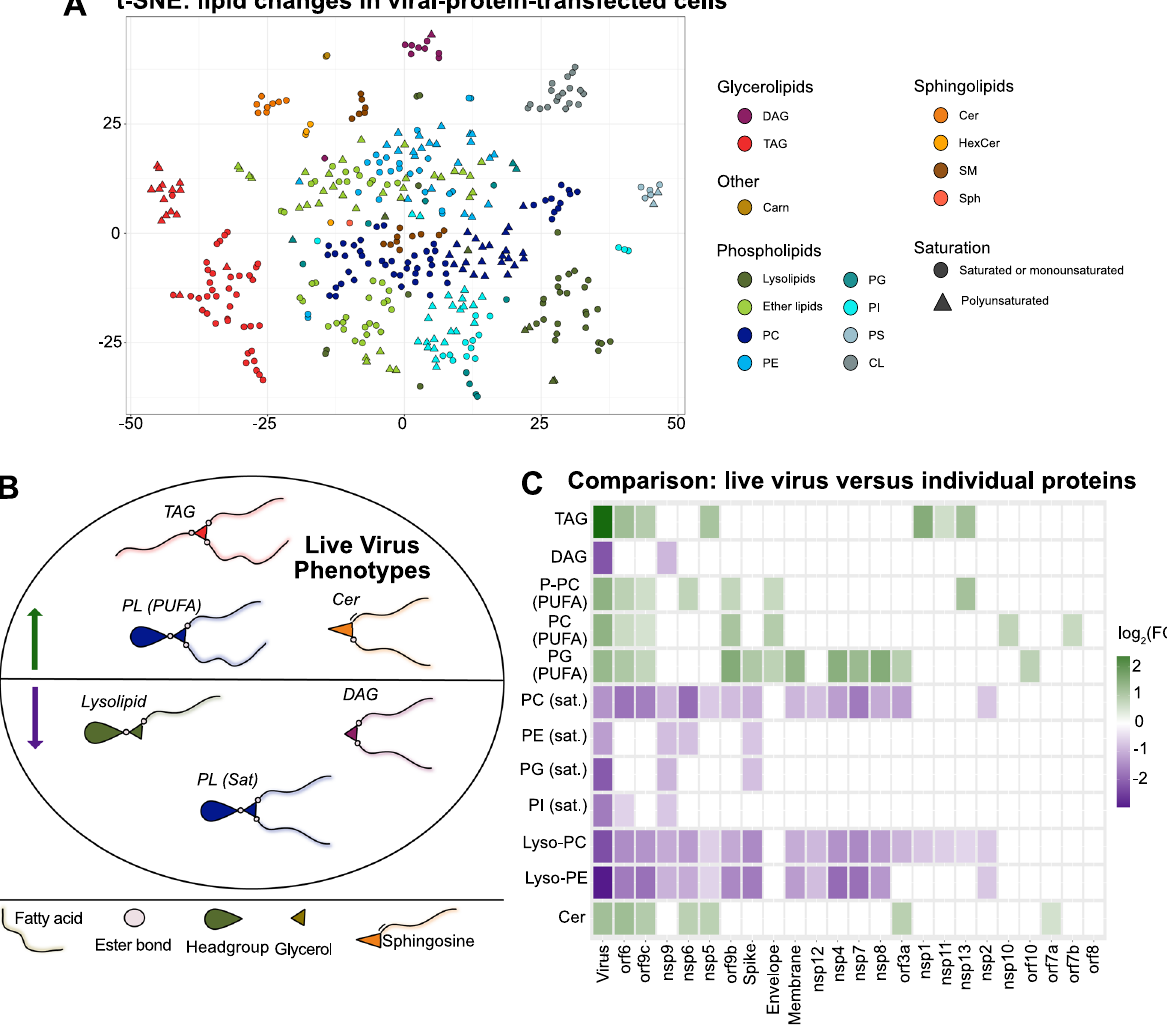
Fig. 3 Individual SARS-CoV-2 proteins recapitulate overlapping lipid features of live infection. A Unsupervised clustering of the normalized lipid species observed in the protein-transfected dataset by t-SNE. Abbreviations same as Fig. 1. B Summary of lipids altered upon infection with SARS-CoV-2 in both HEK293T-ACE2 cells and A549-ACE2 cells. Cer = ceramide; PL (PUFA) = phospholipids bearing polyunsaturated acyl chains; TAG = triacylglycerol; PL (Sat) = phospholipids bearing saturated or monounsaturated acyl chains. C Average fold change within each class described above in each condition, both live virus infection (HEK293T-ACE2 cells) and ectopic protein expression. Only signi fi cantly changed ( P < 0.05, see Figs. 1 and 2 for descriptions of statistical tests in the live virus and transfection conditions, respectively) lipid species were used in this calculation. Source data are provided as a Source Data fi